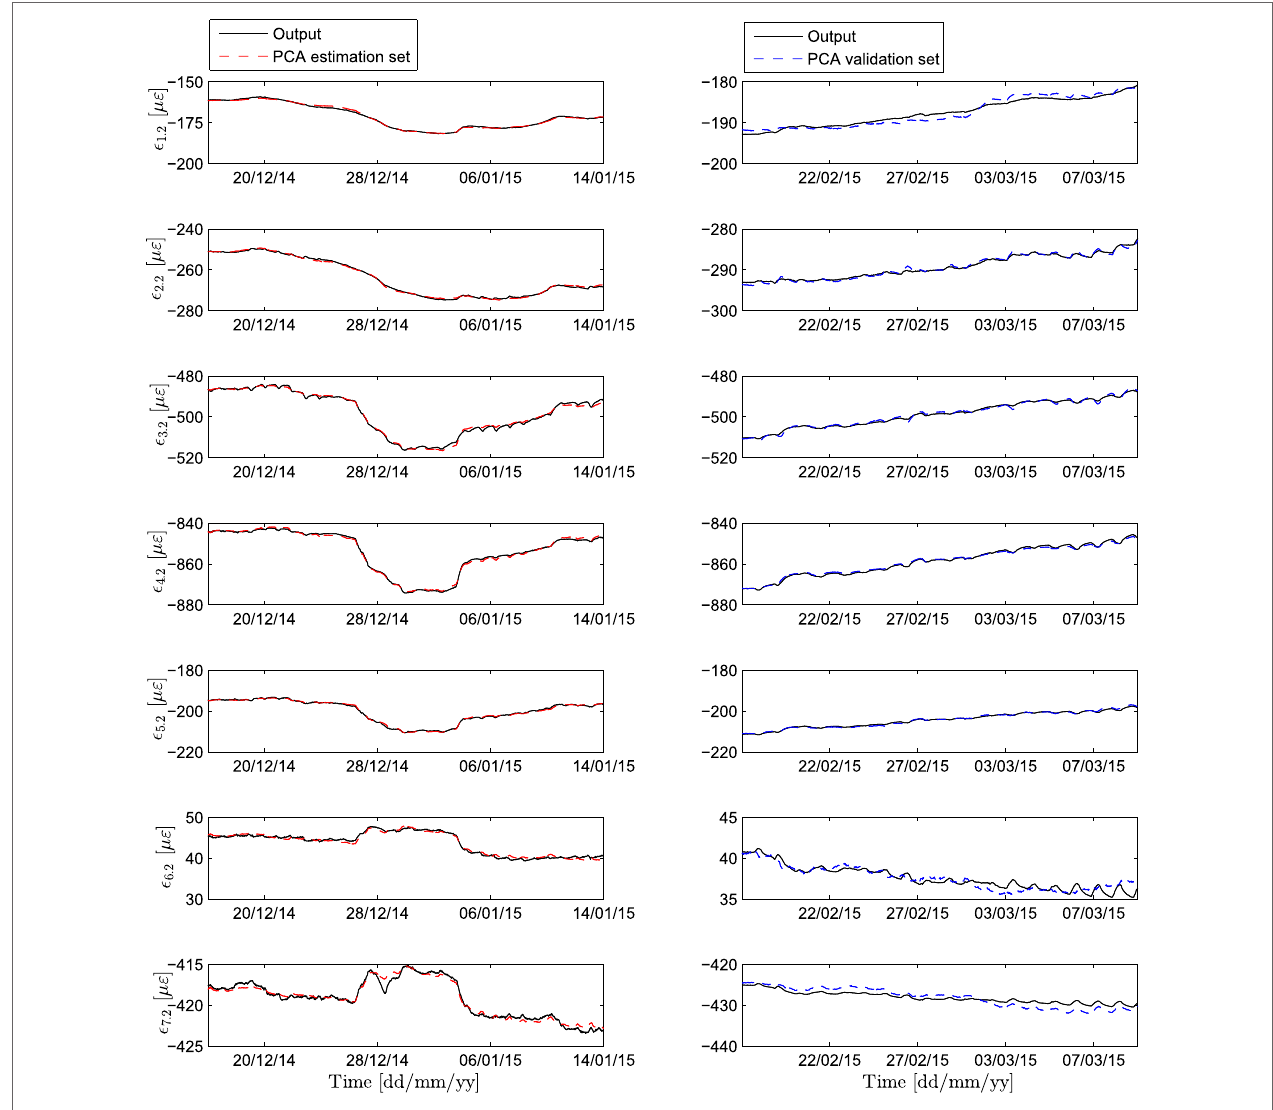
FIGURE 7 | PCA model performance in modeling strain for the estimation and validation data sets